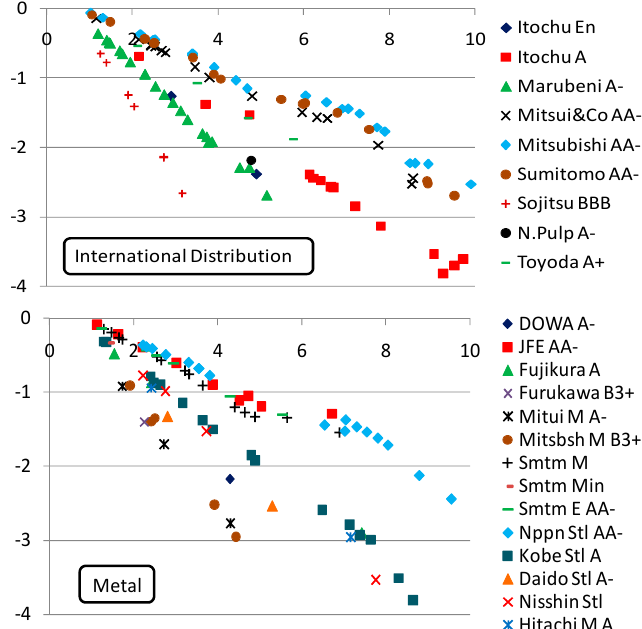
Figure 9. Enterprise-wise CRiPS-plots for firms of the trading and metal industries. Smtm, sumitomo; M, metal; Min, mining; Stl, steel.